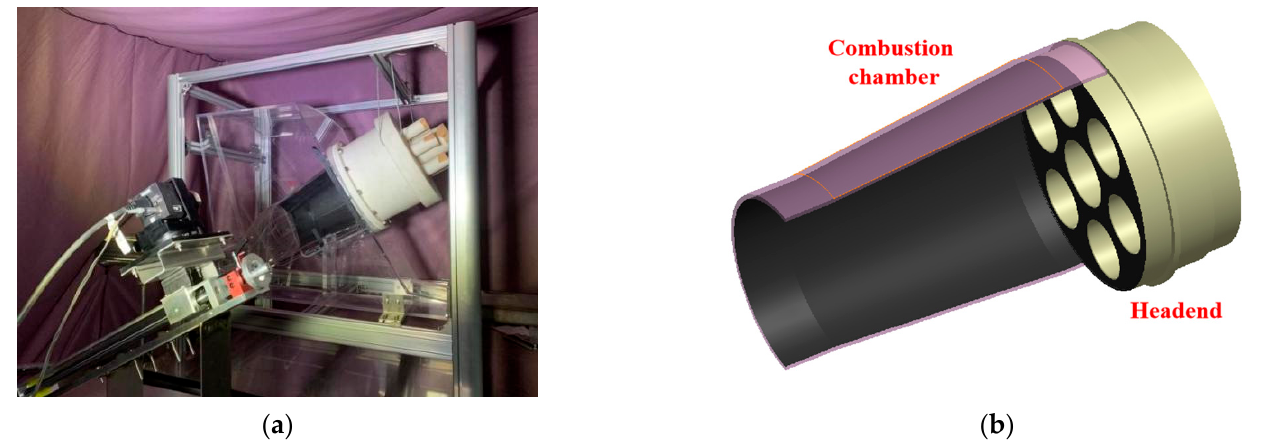
Figure 7. Shading system. ( a ) Shading tent; ( b ) Blackened surfaces inside the model.